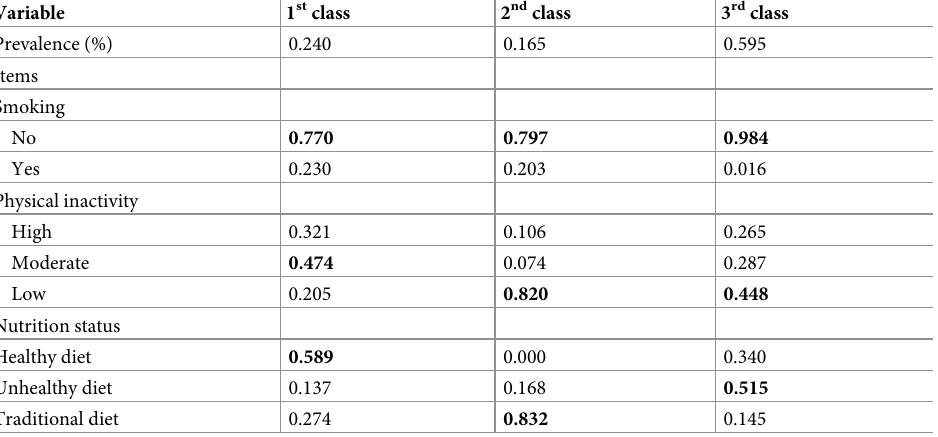
Table 5. The three latent classes models of